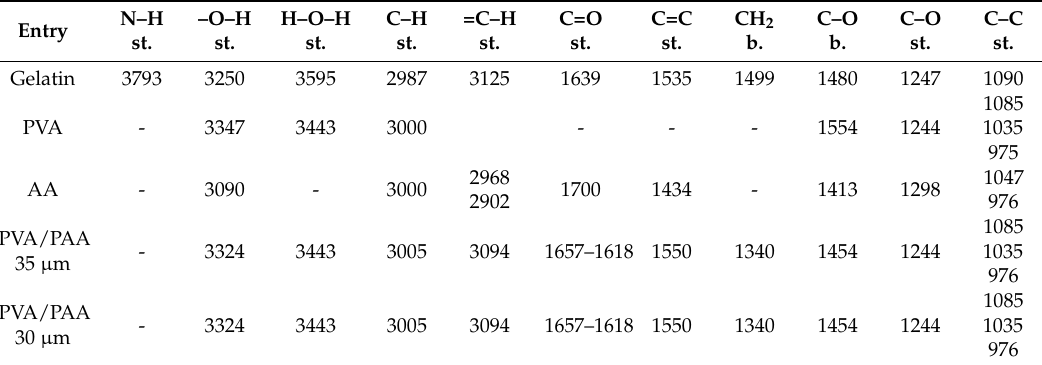
Table 1. Band assignment of IR vibrational modes for gelatin, PVA, acrylic acid (AA), and PVA/PAA films.